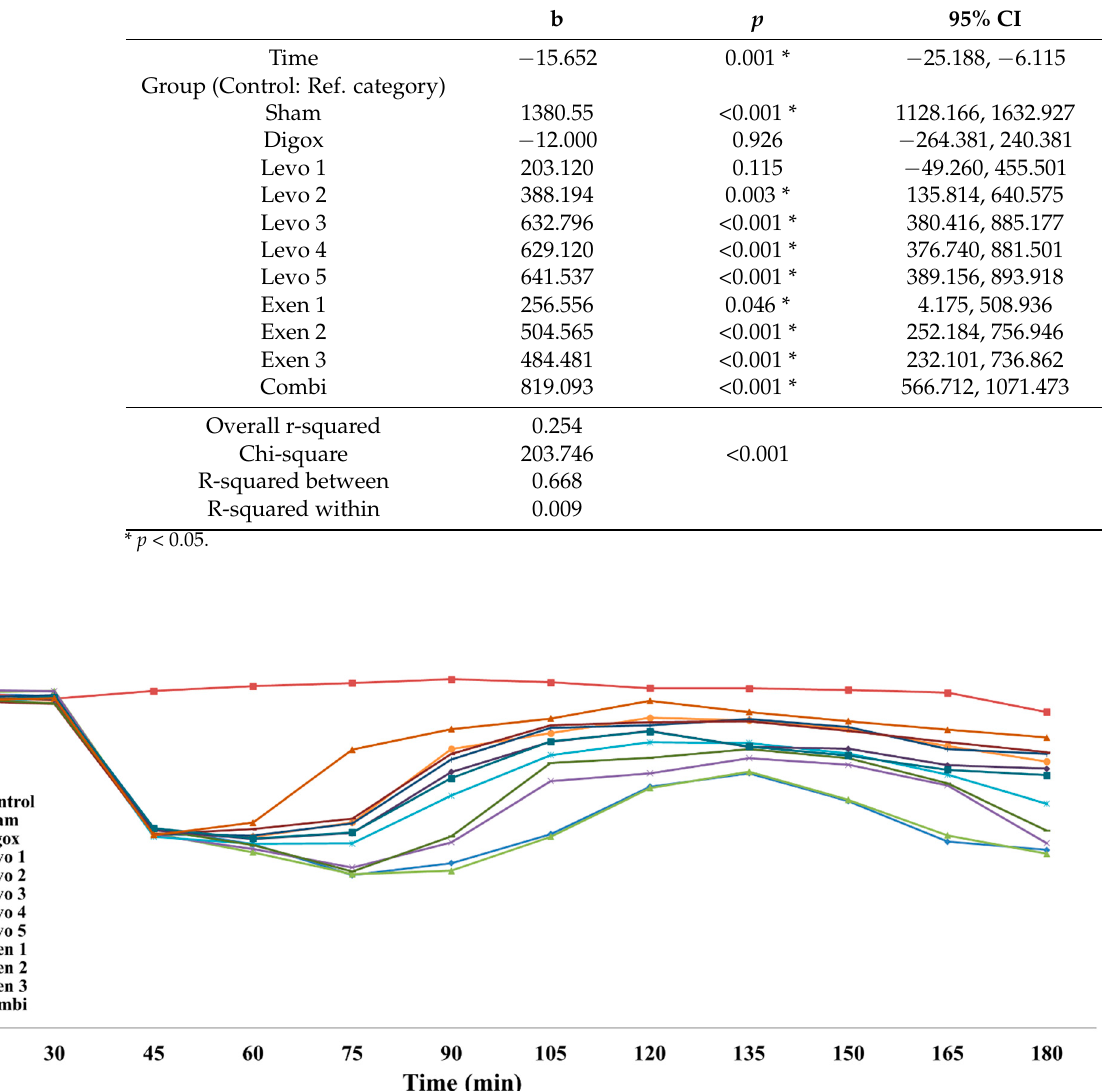
Table 6. Longitudinal analysis for +dP/dt for all groups.